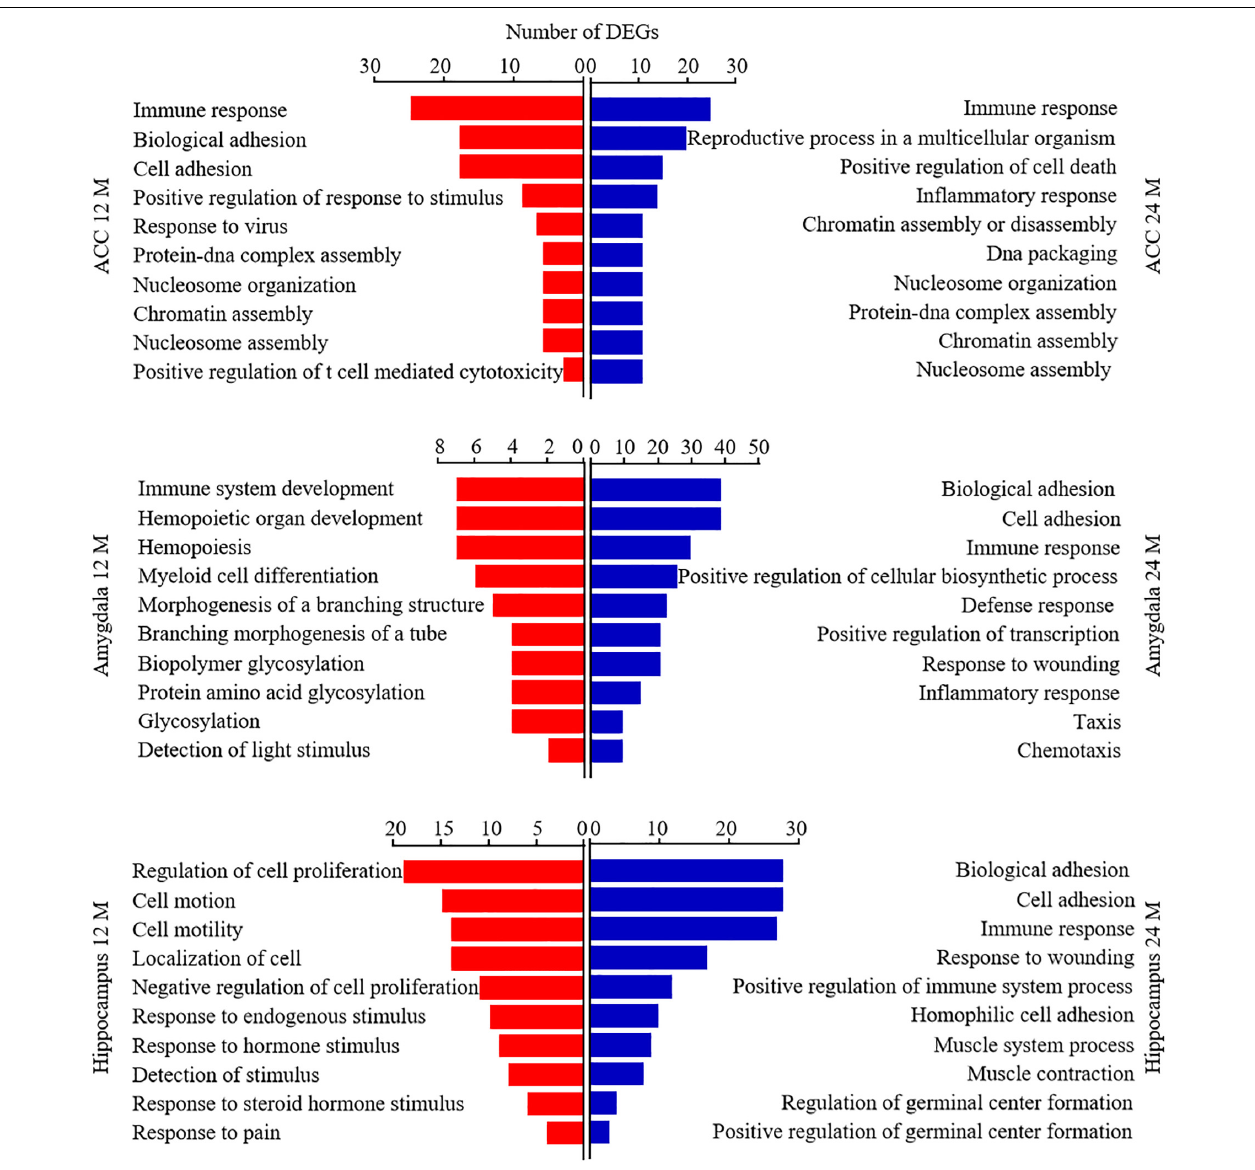
FIGURE 7 | Functional enrichment analysis of the differentially expressed genes (DEGs) in aging mice. Analysis of the Gene Ontology database showed top 10 biological processes of the DEGs in the ACC (top), amygdala (middle), and hippocampus (bottom) from 12- and 24-month old mice according to the P -value of biological process. The DAVID database was used to do the GO enrichment analysis. Red and blue color bars represent 12- and 24-month old mice, respectively.